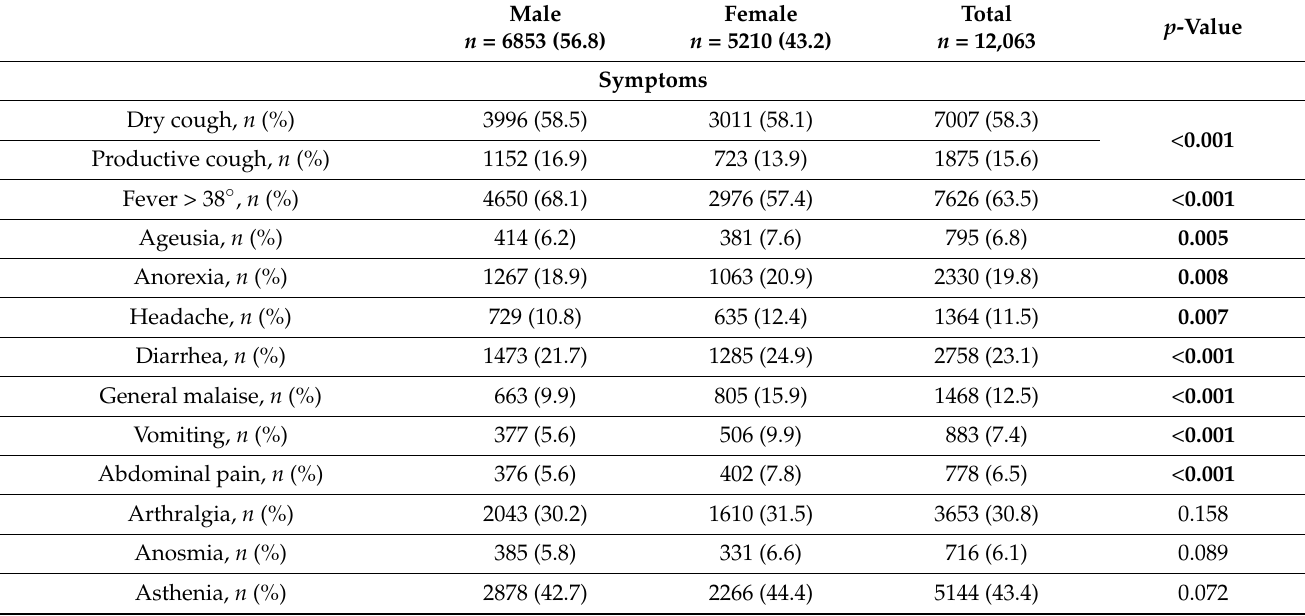
Table 2. Clinical